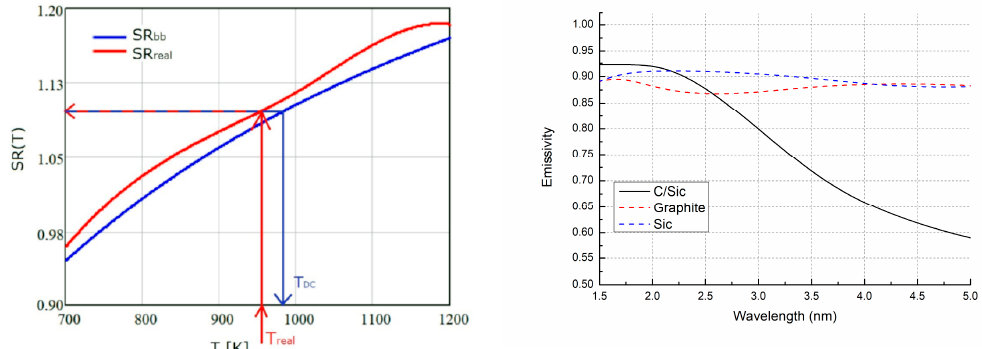
Figure 10. ( Left )—DC temperature evaluation process (T DC ), see text [7]. ( Right )—material emissivity trends versus wavelength found in the literature [6].